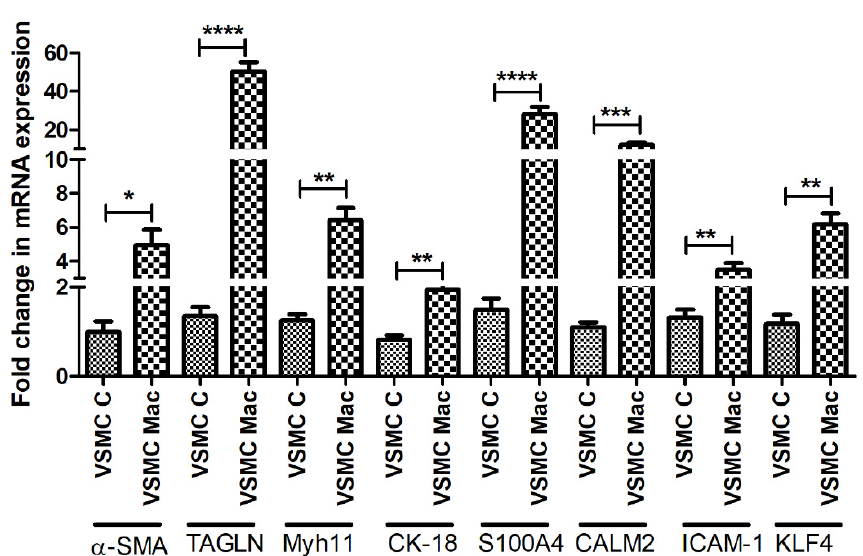
Figure 5. RT ‐ PCR analysis of the effect of M1 macrophages on VSMCs phenotype markers. Alpha ‐ smooth muscle actin ( α -SMA), transgelin (TAGLN), Myosin Heavy Chain 11 smooth muscle (Myh11), cytokeratin (CK) ‐ 18, S100 protein A4 (S100A4), calmodulin 2 (CALM2), Intercellular Adhesion Molecule (ICAM)1, Krüppel ‐ like factor 4 (KLF4). α‐ SMA, TAGLN, and Myh11 (markers for contractile vascular smooth muscle cells (VSMCs)); CK ‐ 18, S100A4, CALM2, and ICAM1 (markers for proliferative VSMCs); and KLF4 (a marker for de ‐ differentiated VSMCs). All data are presented as mean ± standard deviation (SD). p < 0.05 is considered statistically significant. * p < 0.05, ** p < 0.01, *** p < 0.001, and **** p < 0.0001.